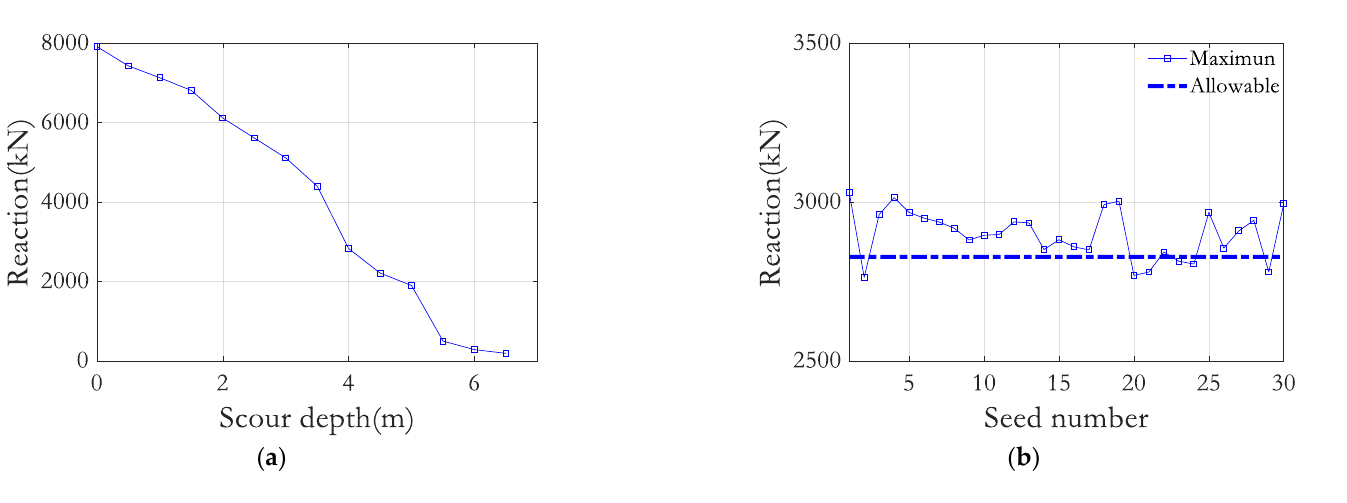
Figure 15. Variation of horizontal reaction: ( a ) allowable reaction; ( b ) reaction at at SD = 4 m.